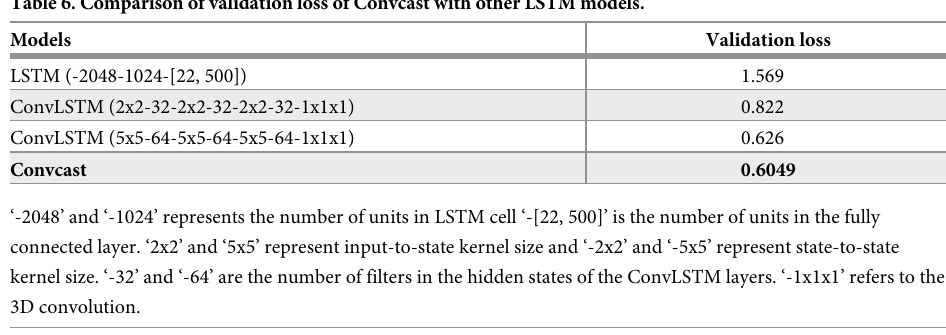
Table 6. Comparison of validation loss of Convcast with other LSTM models.